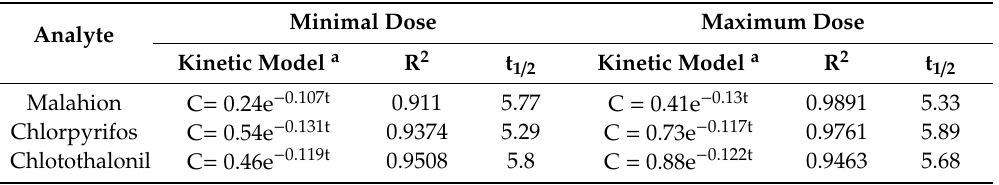
Table 5. Dissipation, t 1 / 2 , and correlation coe ffi cients of studied pesticides. Minimal Dose Maximum Dose Analyte Kinetic Model a R 2 t 1 / 2 Kinetic Model a R 2 t 1 / 2 Malahion C = 0.24e − 0.107t 0.911 5.77 C = 0.41e − 0.13t 0.9891 5.33 Chlorpyrifos C = 0.54e − 0.131t 0.9374 5.29 C = 0.73e − 0.117t 0.9761 5.89 Chlotothalonil C = 0.46e − 0.119t 0.9508 5.8 C = 0.88e − 0.122t 0.9463